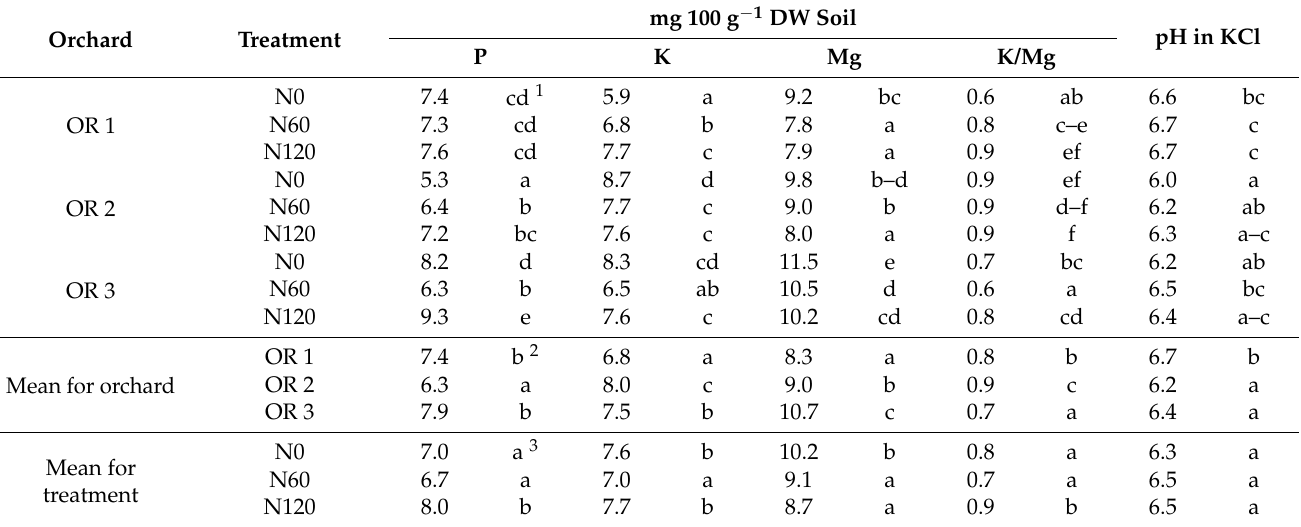
Table 5. The influence of nitrogen fertilization on the content of P, K, and Mg nutrients and on pH in 2010–2013 in depth 21–40